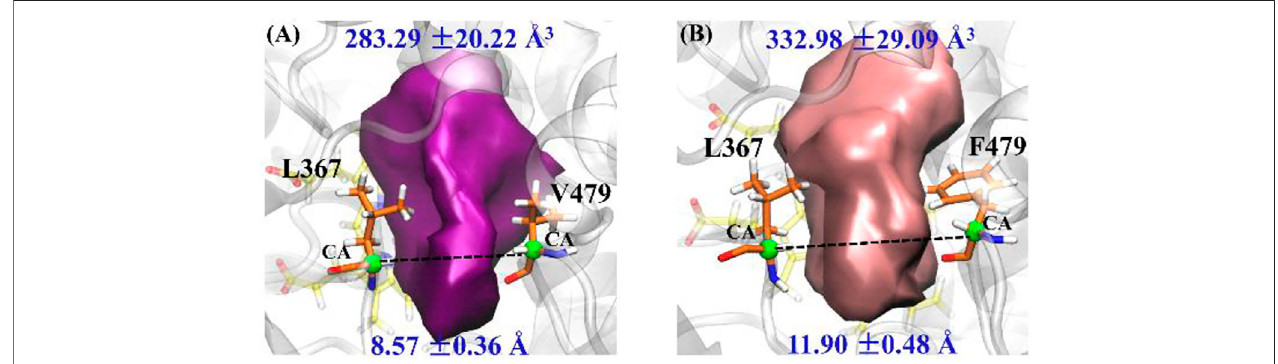
FIGURE4| Representativepocketshapeofabietatriene-boundCYP76AH1: (A) wildtype(wt-abi-Rest)and (B) themutant(mut-abi-Rest).Thepocketvolumeand its standarddeviationareprovided. Thedistance betweentwo α -C atomsofL367andV479(F479 inmutant) isselectedtocharacterizethewidth ofpockets; thedetails are provided in Supplementary Figure S3B .